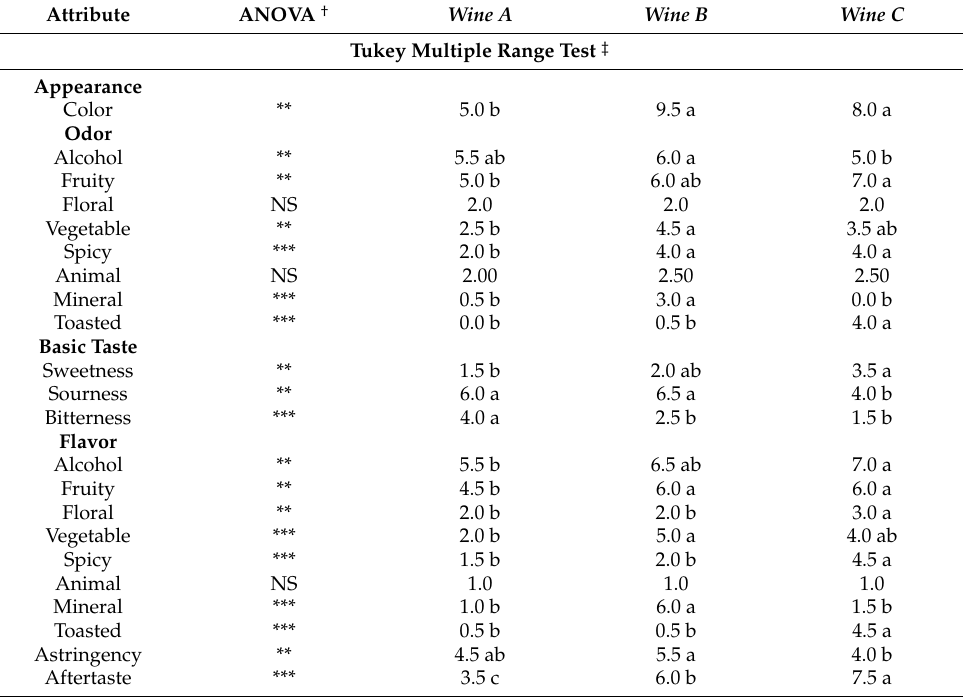
Table 2. Descriptive sensory analysis of the studied wines as affected by the type of vessel used for the aging step ( A : aged in clay- tinaja with non-permeable inner coating; B : aged in clay- tinaja without inner coating; C : aged in oak